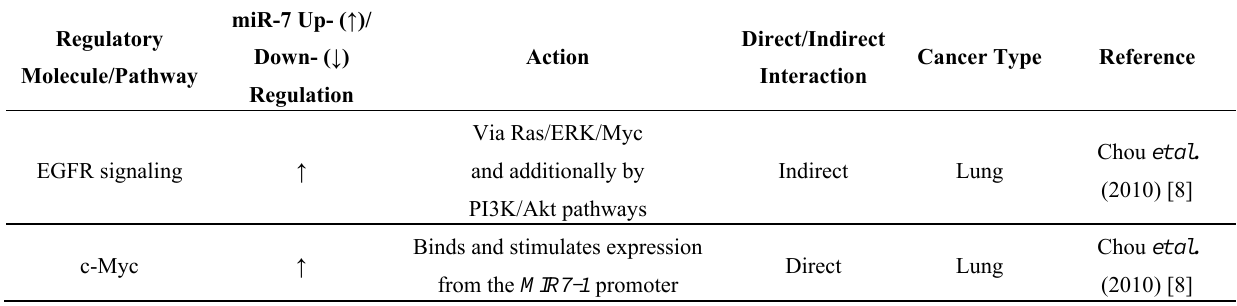
Table 1. Summary of miR-7 regulatory molecules and their effect on miR-7 expression in cancer cell